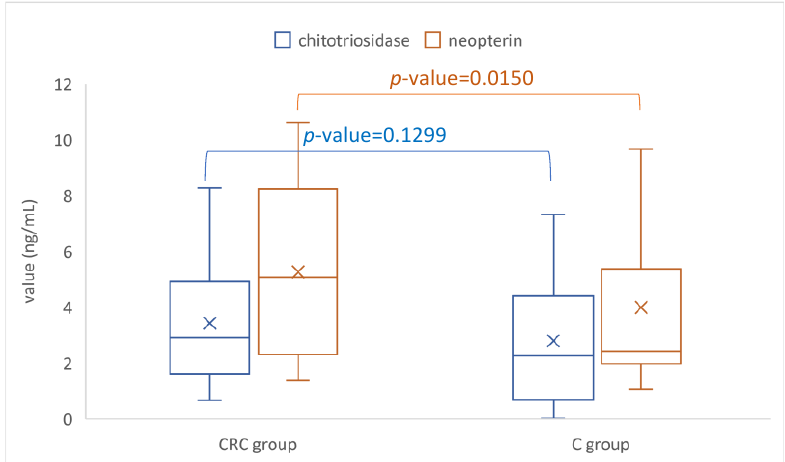
Figure 2. Chitotriosidase and neopterin by groups (CRC = colorectal cancer; C = control). The × in the box indicates the mean value, the line in the box corresponds to the value of the median, the lower and upper bound of the box corresponds to the value of the first (lower) and third (upper) quartile, and the whiskers correspond to the values of minimum and maximum.